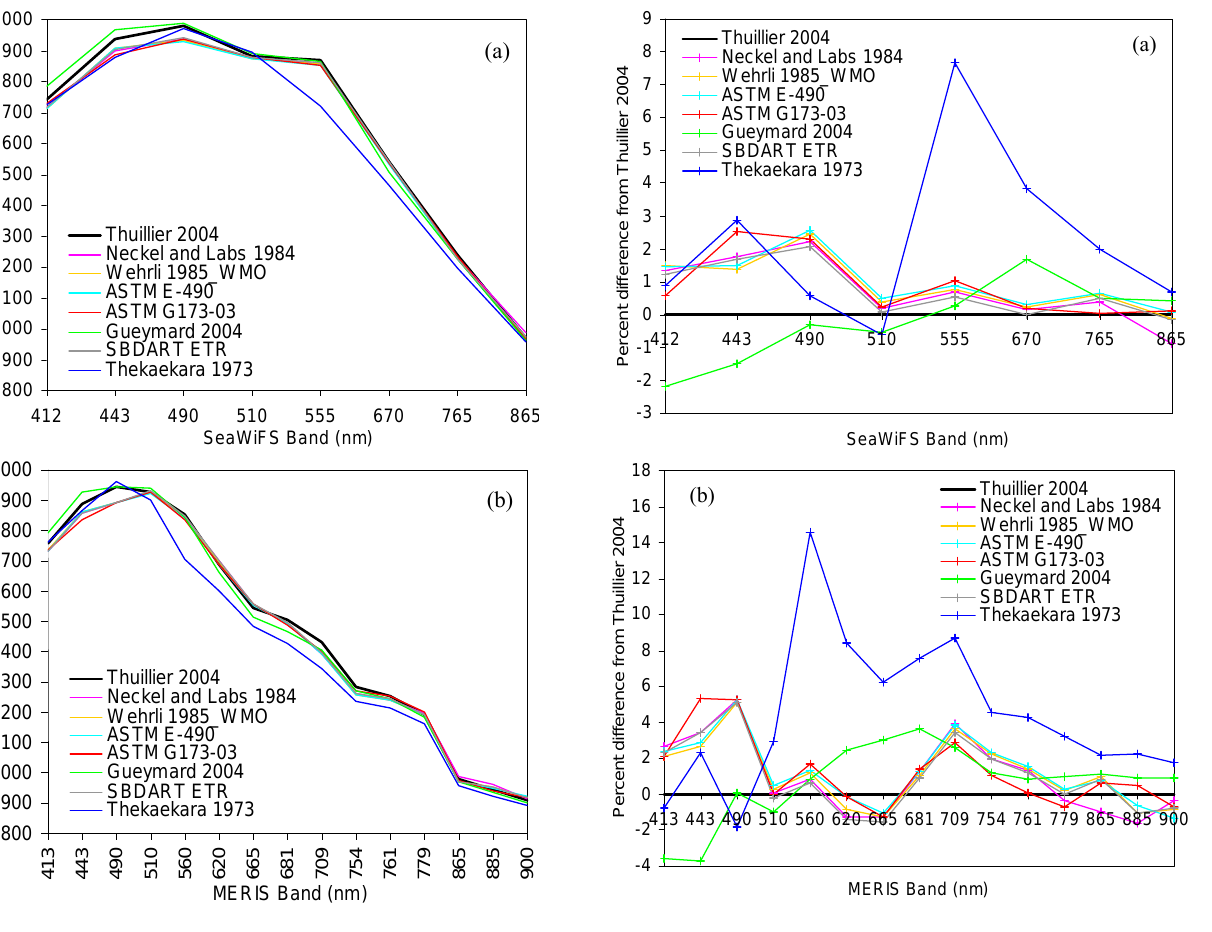
Figs. 4a and b. The in-band irradiances for SeaWiFS (a) and MERIS (b). Fig. 5. The percent differences between the Thuillier 2004 and other Fig. 4. The in-band irradiances for SeaWiFS (a) and MERIS (b) . Figs. 5a and b. The percent differences between the Thuillier 2004 and other spectra in SeaWiFS and spectra in SeaWiFS and MERIS MERIS channels.